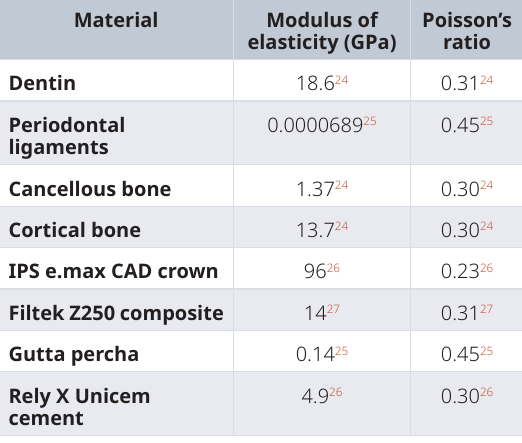
Figure 5. 3D CAD model (left). The model embedded in bone